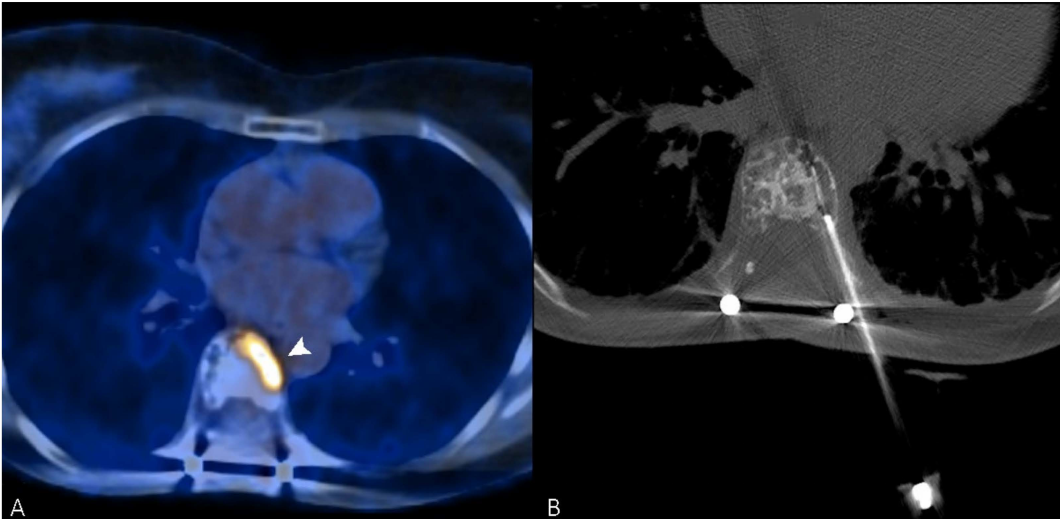
Figure 2. ( A ) PET/CT scan of a 56-year-old woman, which shows an intense uptake of 18F-FDG in correspondence with a painful vertebral metastasis from breast cancer in the body of T7 (arrowhead). ( B ) Radiofrequency ablation of the lesion performed through a transcostovertebral